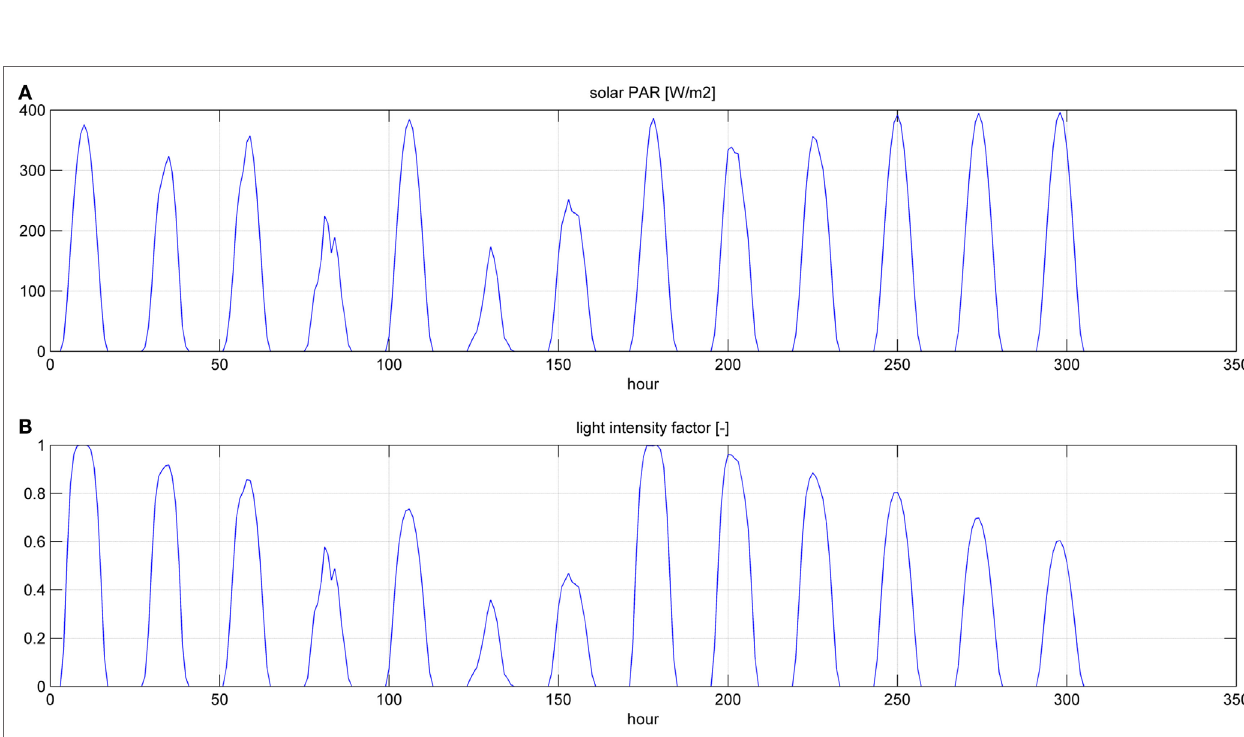
FigUre 5 | Temperatures (a) and temperature factor (B) for a simulation time equal to two hrTs .